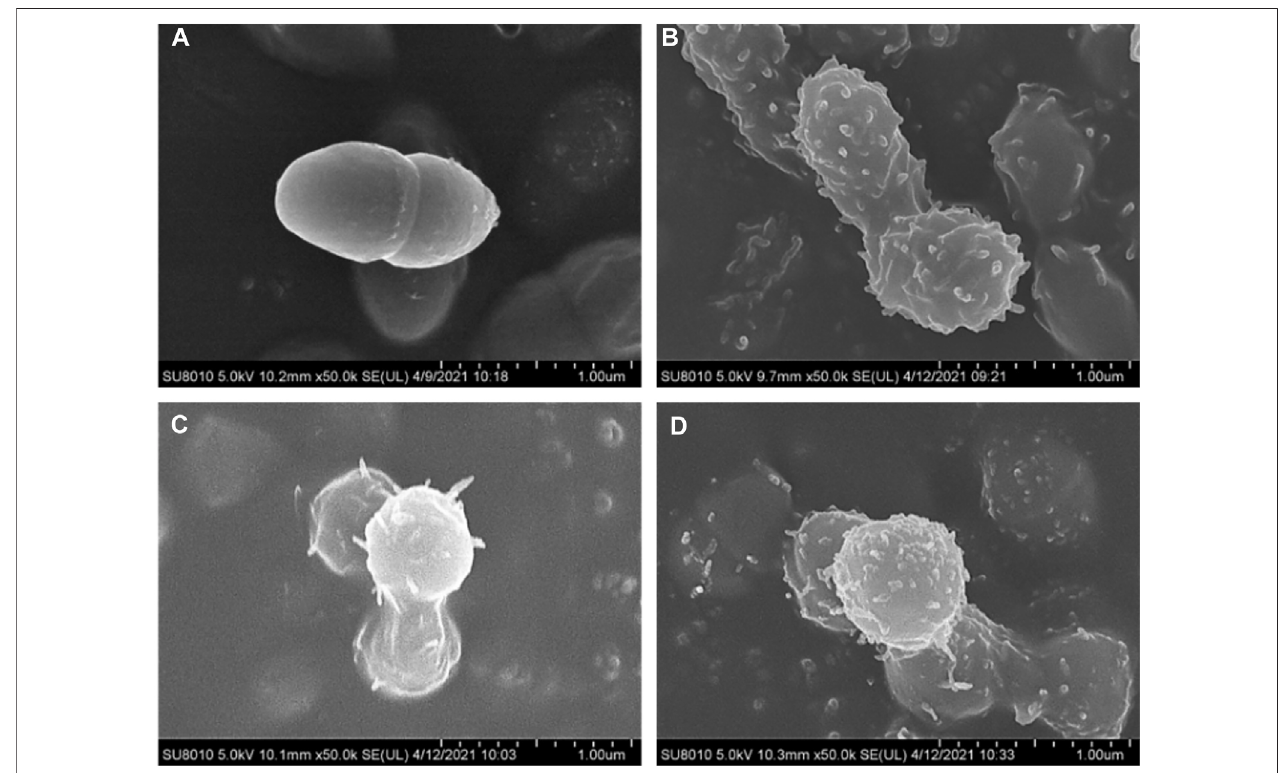
FIGURE 2 | SEM observation of S. pneumoniae ATCC 49619, before (A) and after treatment with 1/2 × MIC concentration of compounds 21b (B) , 21d (C) and 21f (D)